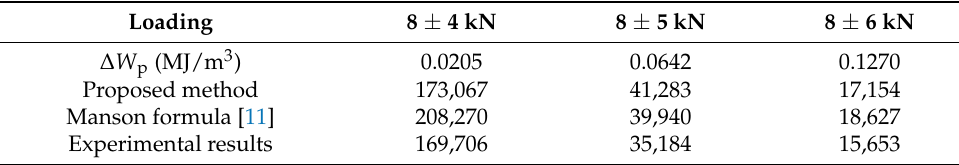
Table 8. Estimated and experimental results of the fatigue life of LC9.